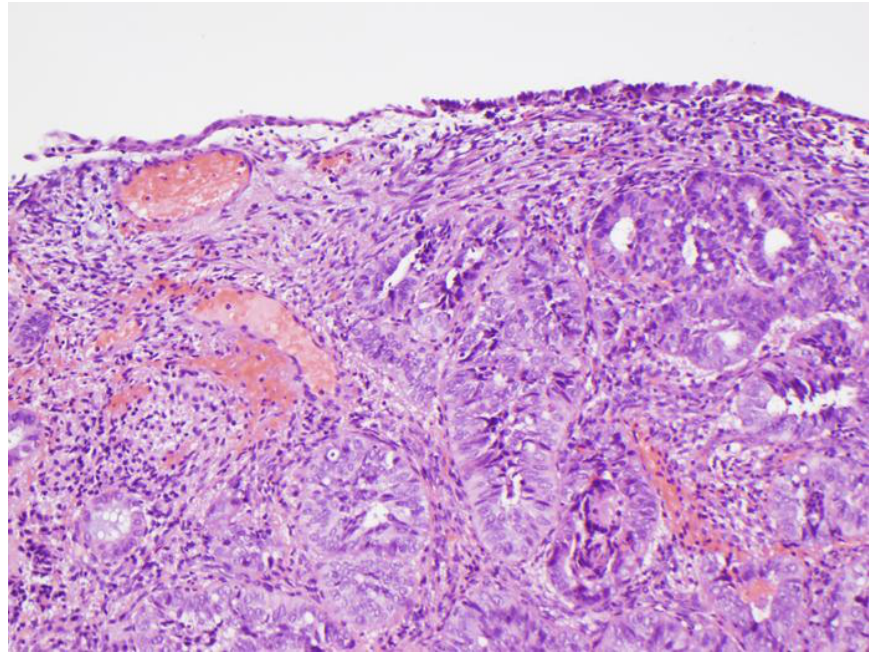
FIGURE 3. Section of ureter with endometrioid adenocarcinoma undermining a thin strip of benign